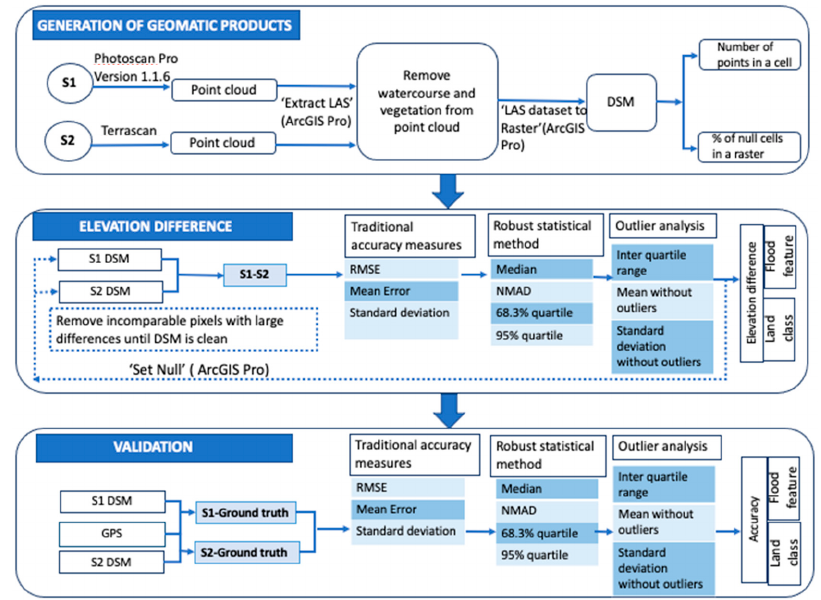
Figure 2. Data processing work fl ow followed in this study.